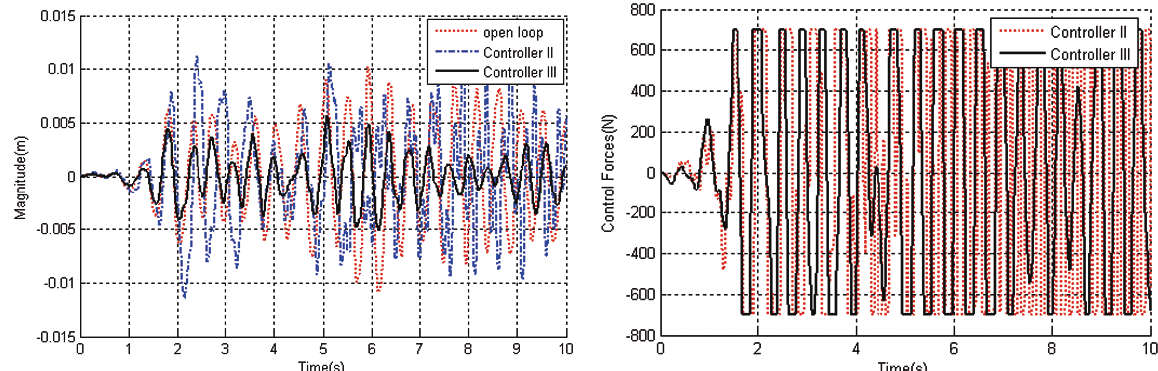
Fig. 4. The displacements of the first floor ( θ 1 i (cid:3) 0 . 4 ,θ 2 i (cid:3) 0 . 2 , τ = 25 ms).